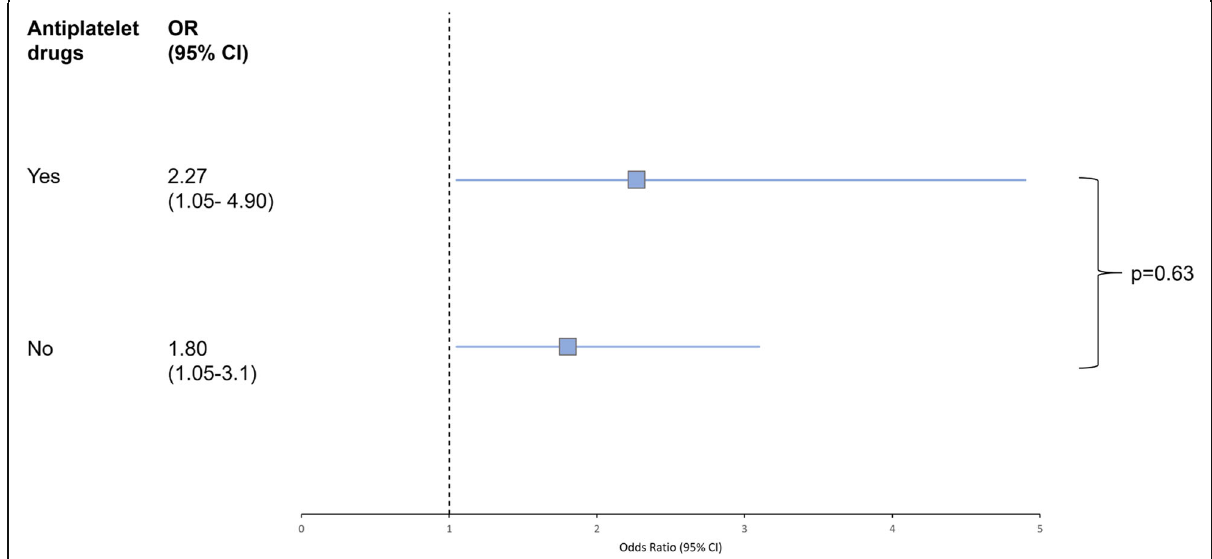
Fig. 1 Effect of alteplase on hemorrhagic transformation. Forest plots demonstrate a significant higher chance of developing any sign of hemorrhagic transformation during follow-up for patients treated with alteplase in both patients with prior APT and without. There was no significant interaction in the corresponding unconditional logistic regression